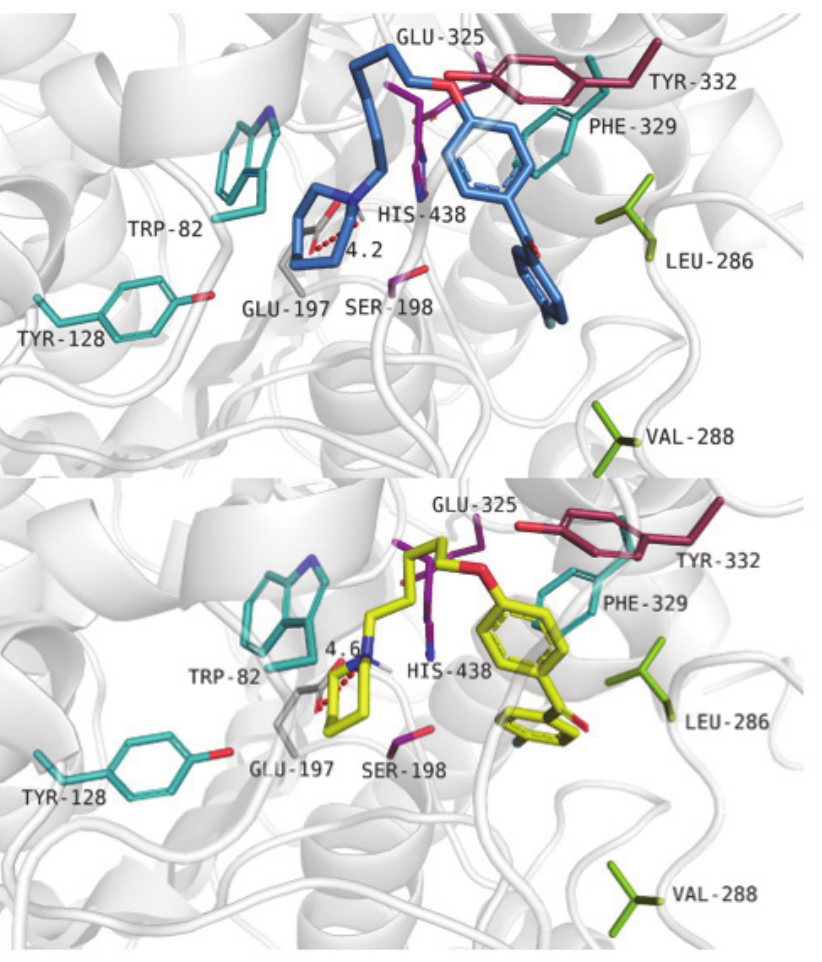
Figure 9. Binding mode of compound 35 ( upper panel ) and ligand 6 ( lower panel ) within the butyrylcholinesterase active site. Residues colored in purple—catalytic triad, blue—anionic site, pink—peripheral anionic site, green—acyl pocket.